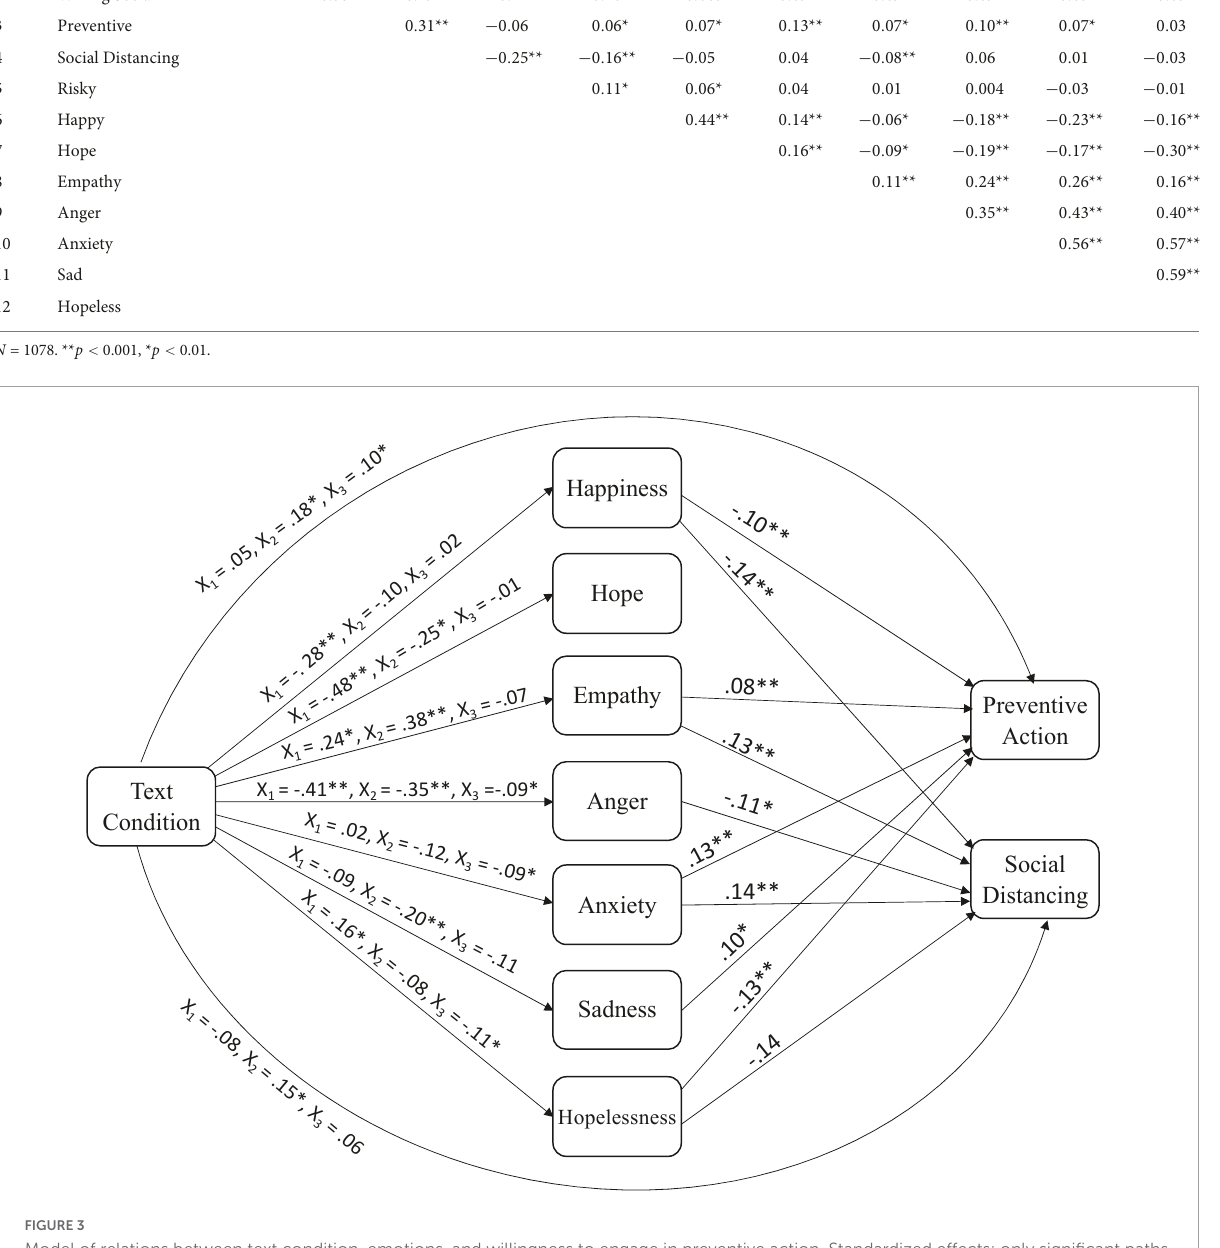
results revealed no significant differences between conditions for the seven items on the scale, all p > 0.05. For engagement in risky behaviors (the other seven items for social distancing and isolation), results revealed a significant omnibus test of the direct effect of text condition on